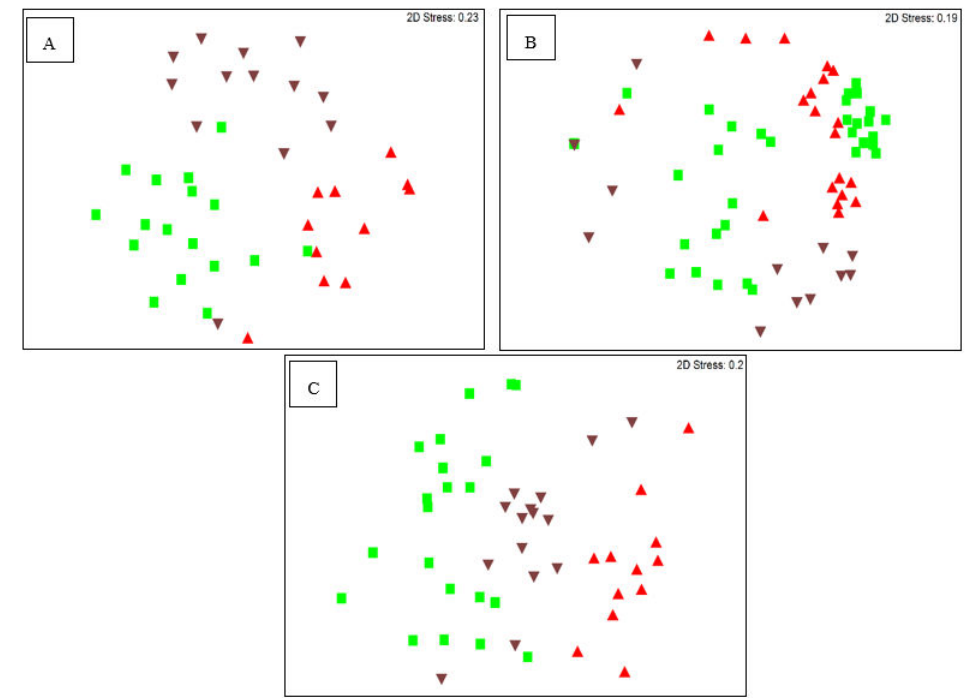
Figure 1. Nonmetric multidimensional scaling (nMDS) plots showing ( A ) Alphaproteobacteria, ( B ) Betaproteobacteria and ( C ) Gammaproteobacteria communities from P. colorata leaf (green square), stem (red upright triangle) and root (brown inverted